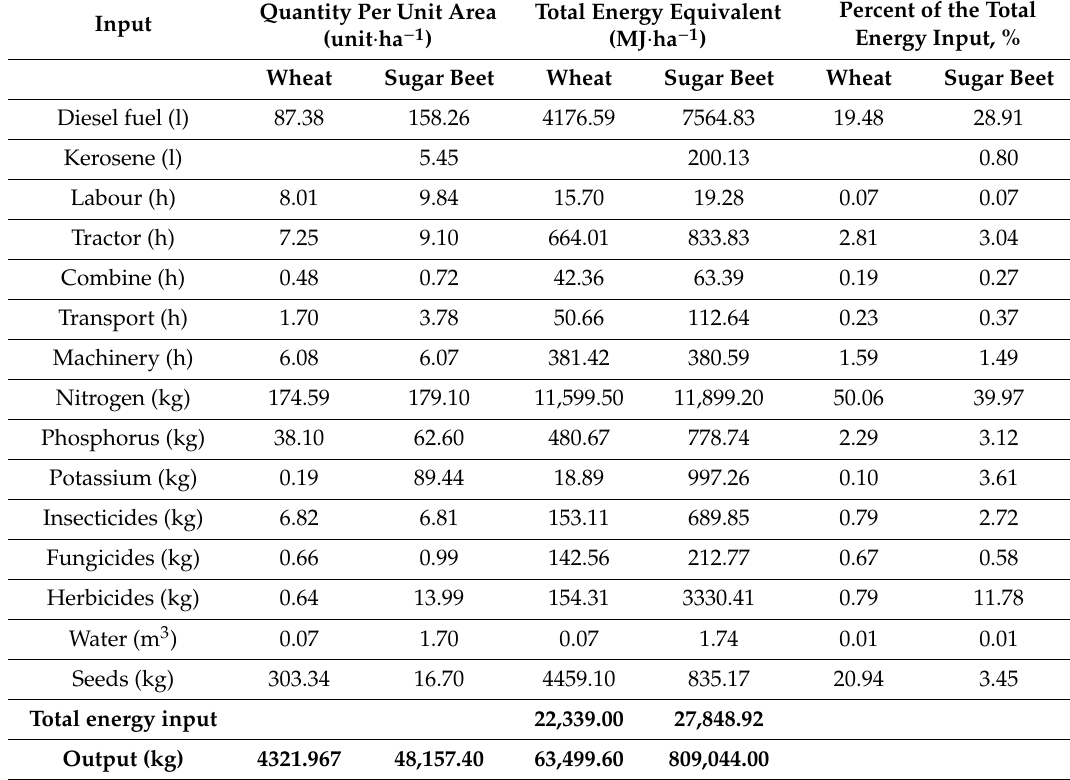
Table 1. Energy inputs and output in wheat and sugar beet